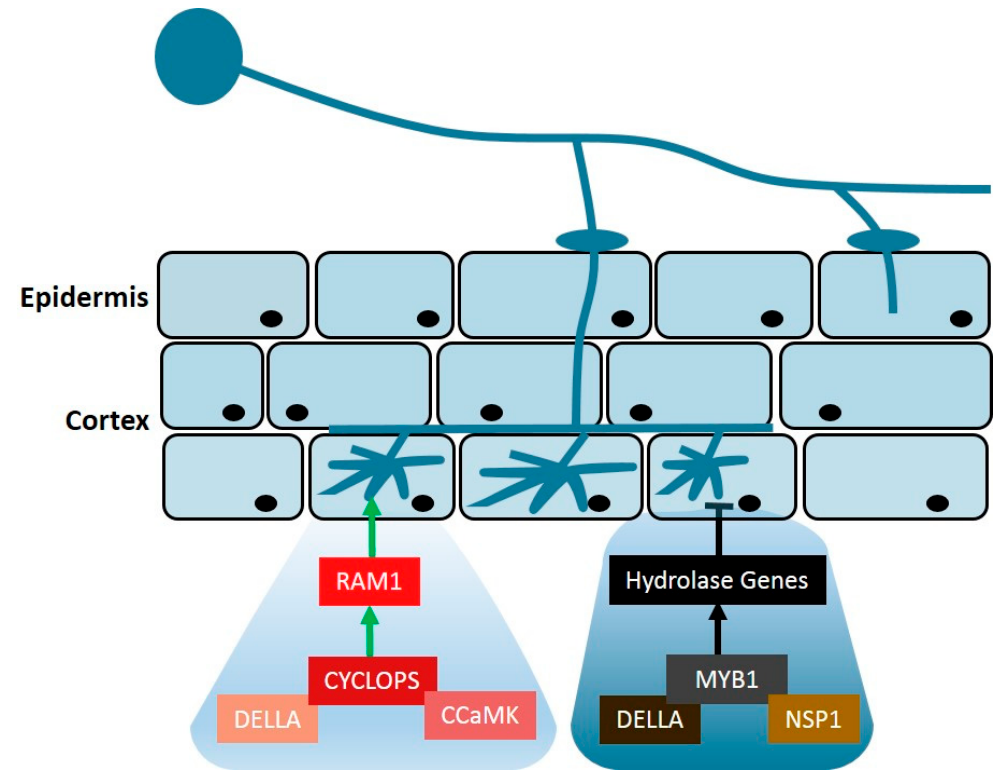
Figure 2. The function of the DELLA proteins in the arbuscule branching and degeneration. In legume, CYCLOPS forms a protein complex by interacting with DELLA and CCaMK, to positively regulate the expression of RAM1 required for the formation of arbuscule [45]. Additionally, MYB1 forms a protein complex by interacting with DELLA and NSP1 to induce the expression of hydrolase genes enhancing the degeneration of arbuscule [48].